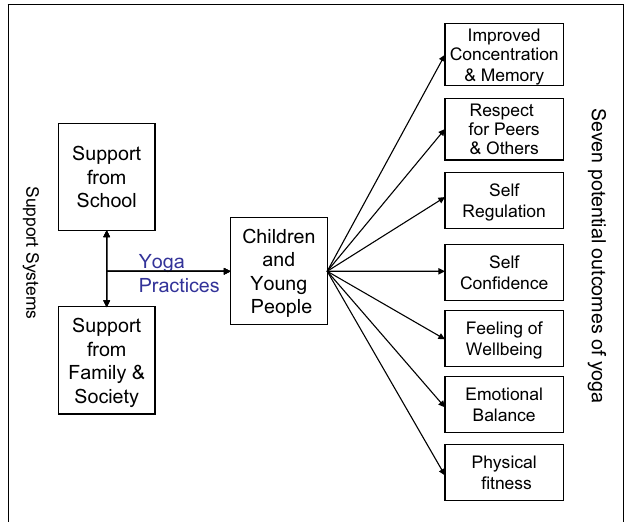
FIGURE 1 |Yoga forYoung People’s Mental Health andWellbeing